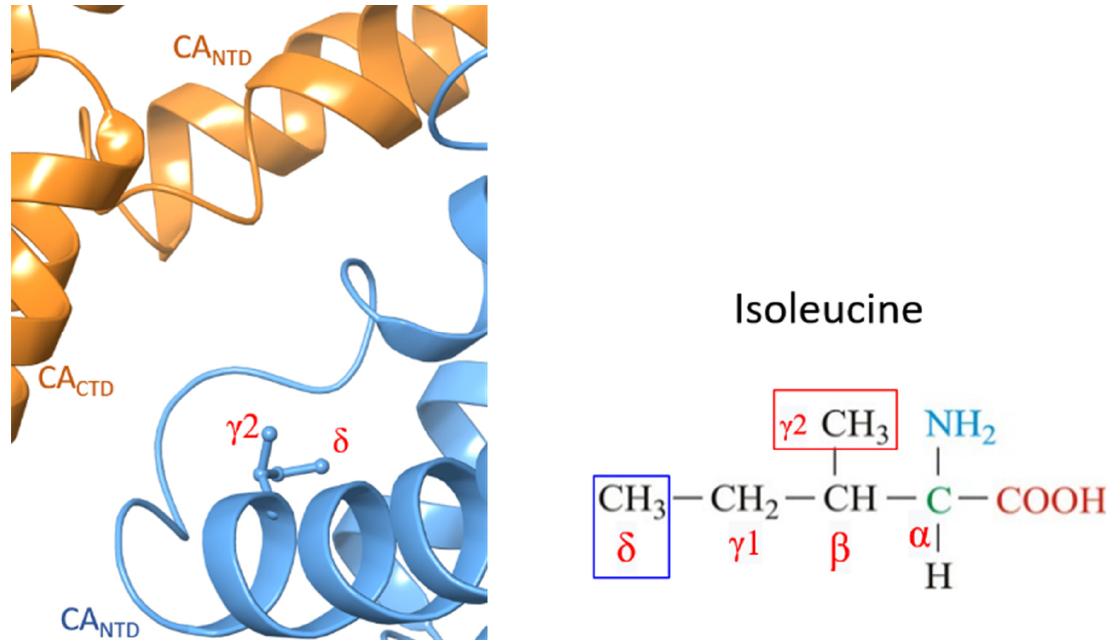
Figure 3. Structure of the apo pocket of the M66I CA mutant from MD. Isoleucine 66 is illustrated by the ball and stick. One CA monomer is illustrated by the blue cartoon, while the neighboring CA monomer is illustrated by the orange cartoon.